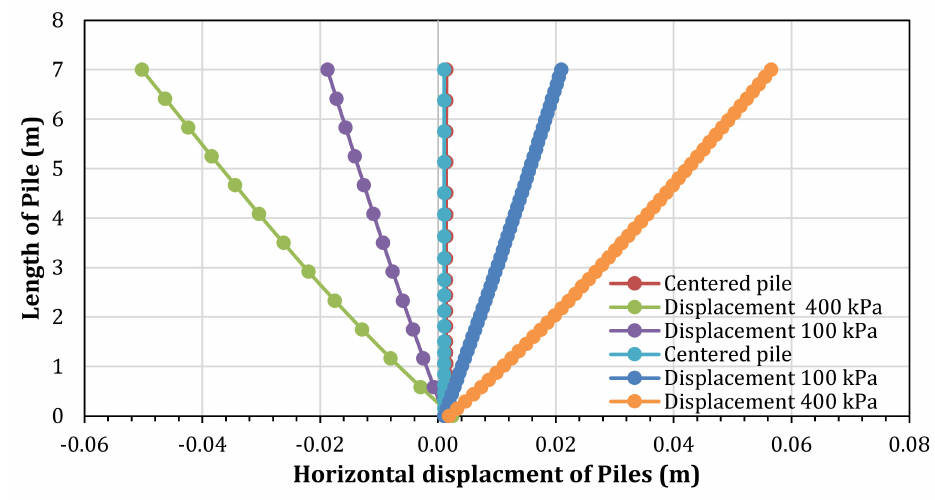
Figure 19. Effect of lateral swelling on horizontal